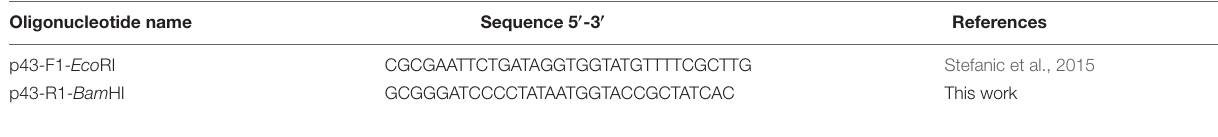
TABLE 2 | Oligonucleotides used in this